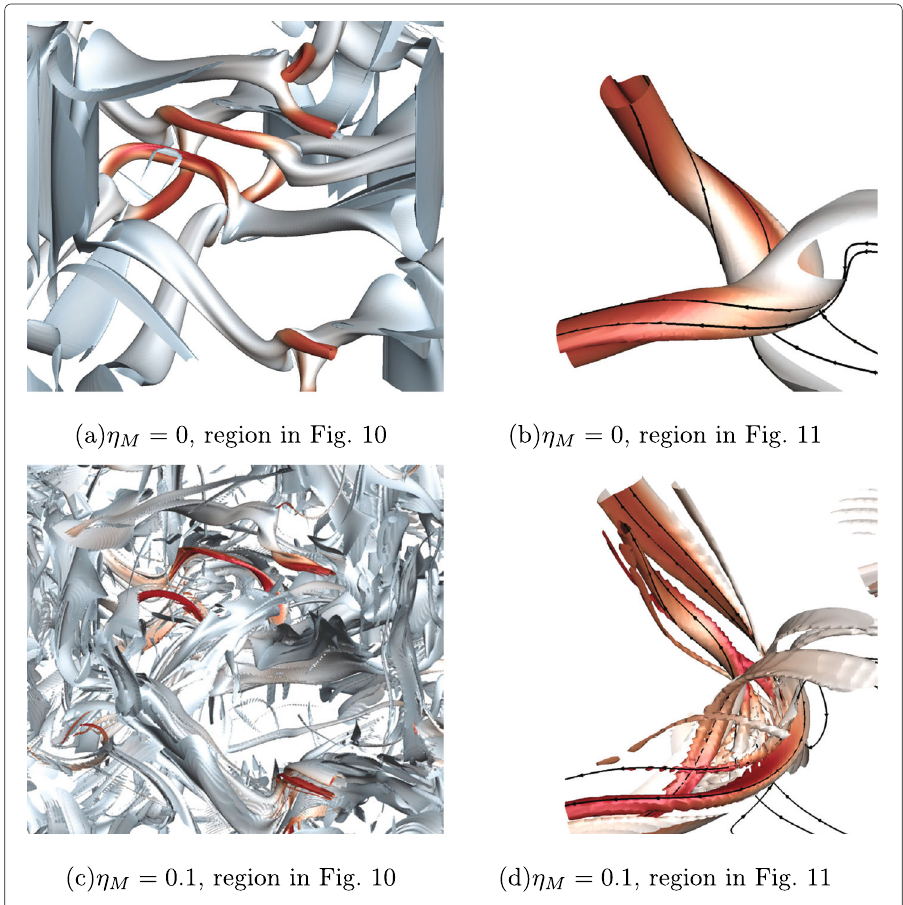
Fig.12 Close-up views of VSF isosurfaces within the same regions in Figs. 10 and 11 at t = 1.0 in cases M0 and M2. The color bar is the same as that in Fig. 9. The VSF isosurfaces with | ω | < | ω | max / 10 in ( a ) and ( c ) and with / 3 in ( b ) and ( d ) are cut off for clarity. Some vortex lines are integrated from points on the surface | ω | < | ω | max